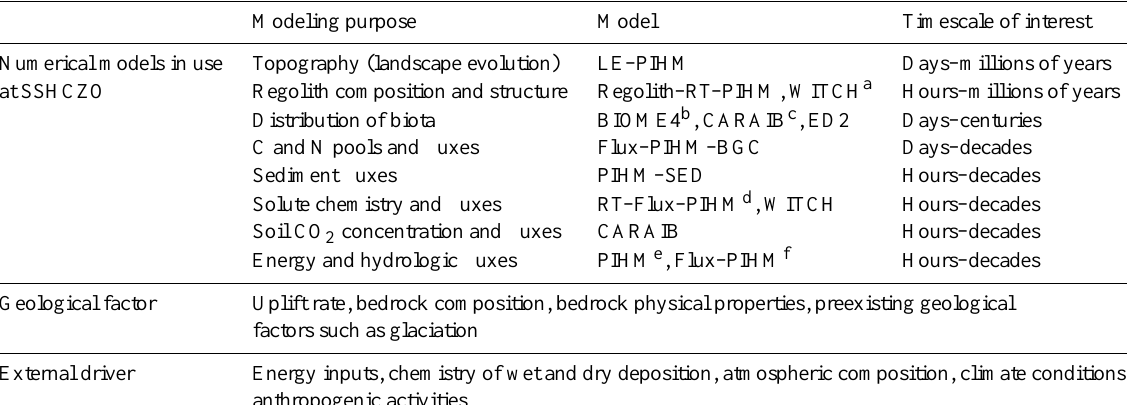
Figure 1. Critical zone science investigates the architecture, character, and dynamics of the earth surface from vegetation canopy to deep groundwater on all timescales. As rock of a certain lithology and structural character is exposed at the earth’s surface due to uplift or erosion, climate-driven inputs transform it to regolith. This transformation, shown in the black box, is catalyzed by biota (a feedback which is not shown explicitly). Gradients of properties describing the CZ are shown in brown boxes. These gradients can become time-independent (steady state) due to the many feedbacks which are not shown. Boxes are placed from left to right to note the increasing duration of exposure time needed to achieve such steady states. For example, depth profiles of regolith composition can become constant when the rate of erosion equals the rate of weathering advance in the presence of feedbacks related to pore water chemistry, soil gas composition, and grain size. The figure emphasizes that gradients to the left can achieve steady state quickly compared to properties to the right. Therefore, properties to the left are often studied as if the properties in boxes to the right are constant boundary conditions. However, over the longest timescales, all properties vary and can affect one another. The complexity of feedbacks (which are not shown for simplicity) can also create thresholds in system behavior. Red boxes indicate drivers and blue arrows are WEGSS fluxes (upward arrows for aboveground and downward arrows for belowground). Table 1. Designing a suite of CZ models. PIHM: Penn State Integrated Hydrologic Model; LE–PIHM: PIHM with landscape evolution mod- ule; Regolith–RT–PIHM: PIHM with regolith formation and reactive transport modules; CARAIB: CARbon Assimilation In the Biosphere; ED2: Ecosystem Demography model; Flux–PIHM–BGC: PIHM with surface heat flux and biogeochemistry modules; PIHM–SED: PIHM with sediment transport module; RT–Flux–PIHM: PIHM with surface heat flux and reactive transport modules; Flux–PIHM: PIHM with surface heat flux